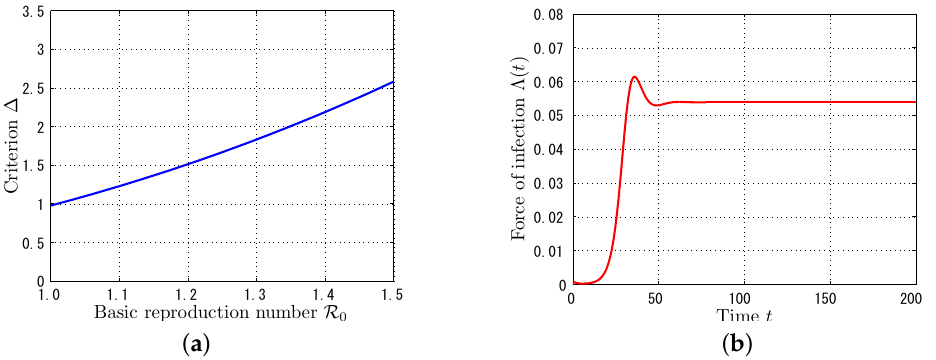
Figure 2. Numerical confirmation of condition (17) and asymptotic stability of the endemic equilibrium E ∗ for the case of a chlamydia-like sexually transmitted disease: ( a ) Variation of ∆ defined in (17) for